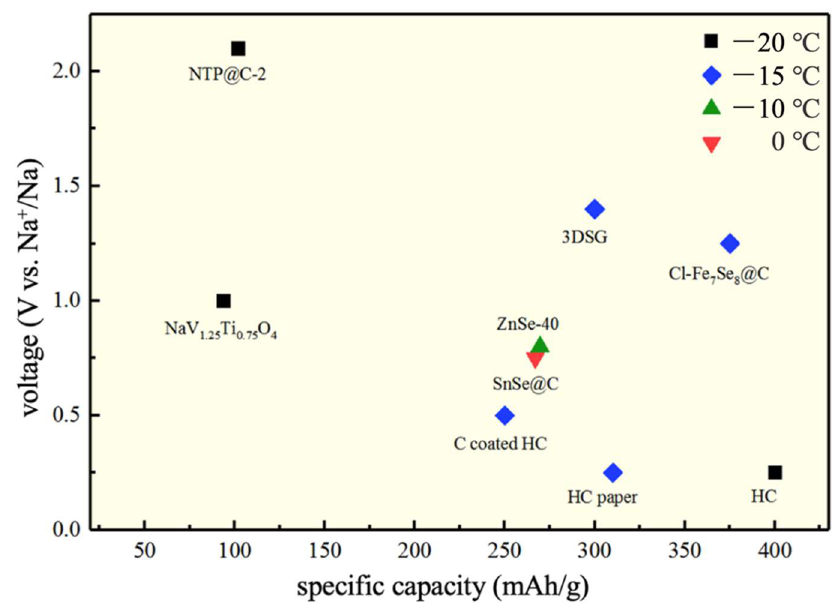
Figure 9. Nine different representative anode materials in low temperatures which are NaV 1.25 Ti 0.75 O 4 at a 0.2 C rate [55], carbon-covered NaTi 2 (PO 4 ) 3 with Na 3 V 2 (PO 4 ) 3 at a 0.2 C rate [52], carbon-coated HC at a 0.1 C rate [42], SnSe@carbon nanofibers at a 1 C rate [48], ZnSe@carbon nan- otubes at a 1 C rate [49], amorphous selenium-coated reduced graphene oxide nanosheets at a 2 C rate [46], HC paper and carbon microbelts at a 0.5 C rate [43], coral-like Fe 7 Se 8 @carbon nanorods at a 0.5 C rate [50], and HC at a 0.1 C rate [44], from left to right,